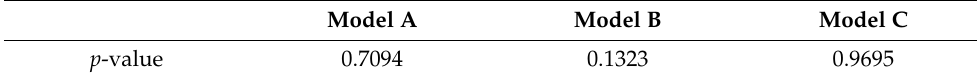
Table 4. Heteroskedasticity test.